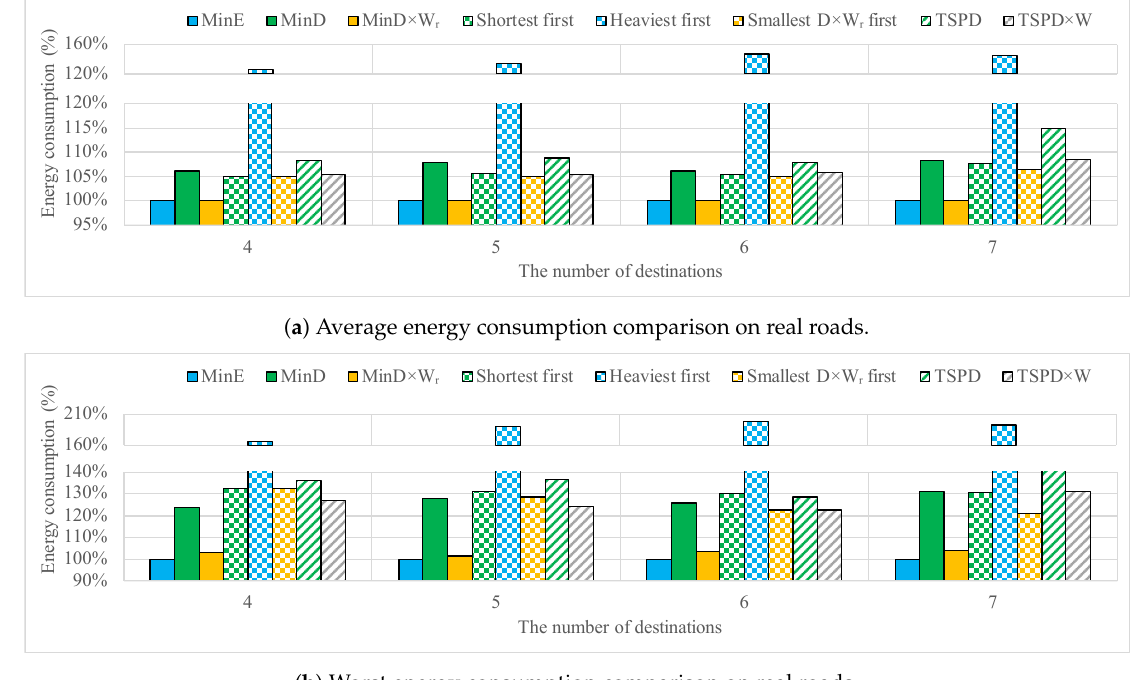
Figure 12. Energy consumption for different metrics (exhaustive exploration) on real roads. Similar to Figure 7a, the leftmost blue bars (MinE) represent energy consumption by the energy-optimal routes among all routes. This is the reference value to compare with the other results. Bars in the plot are in the same order as in Table